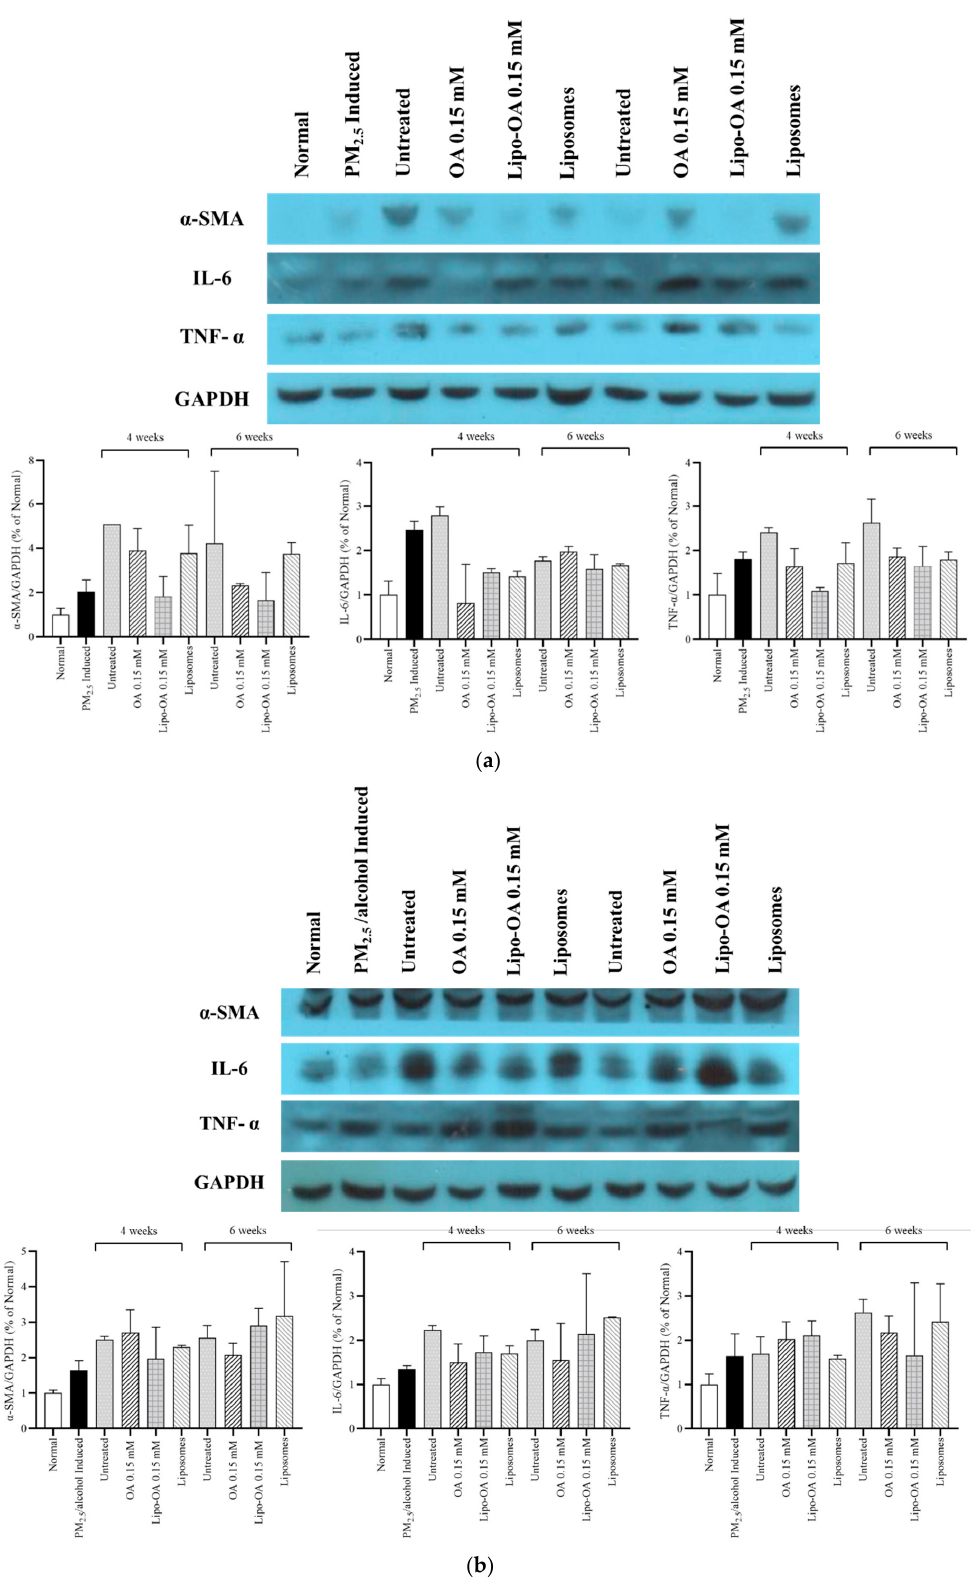
Figure 7. Western blot analysis for α SMA, IL-6, and TNF- α in livers with ( a ) PM 2.5 -induced inflam- mation; and ( b ) PM 2.5 and alcohol-induced inflammation after treatment with or without 0.15 mM OA, 0.15 mM Lipo-OAs, or pure liposomes. The semiquantitative levels of α SMA, IL-6, and TNF- α were determined using ImageJ (n = 2).